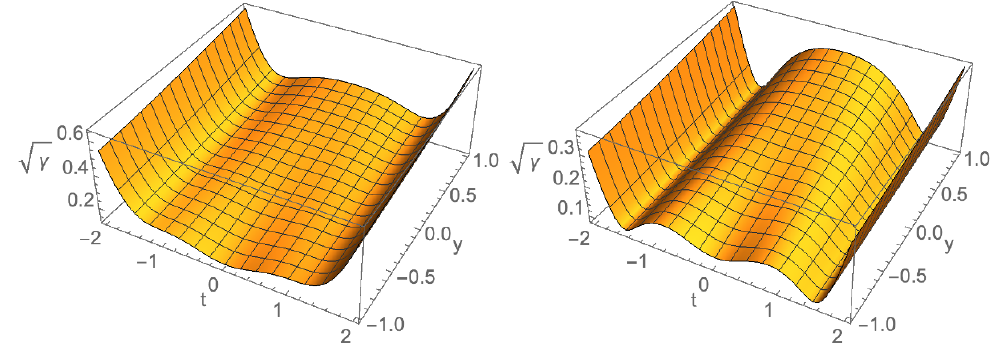
Figure 3 . Plots of the average local scale factor (cubed) as a function of y and t . The solutions can be significantly inhomogeneous: for instance there can be one bounce near y = near y = +1 (left panel, with α = 1 / 2 , σ = 10 , q 1 = q 2 = 0) or two bounces on one side and three on the other (right panel, with α = 1 / 2 , σ = 11 , q 1 = q 2 = 0). All our plots have (cid:24) 2 = 3 , µ =